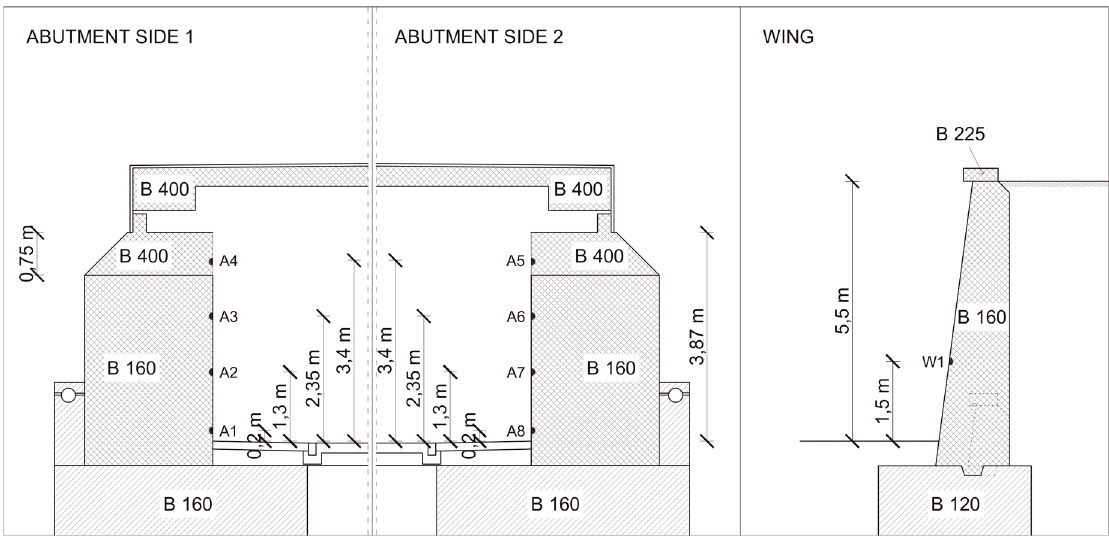
Figure 4. Sketch of measuring carbonation depth x c (46) on the Weikendorf bridge, for wings (W) and abutments (A).